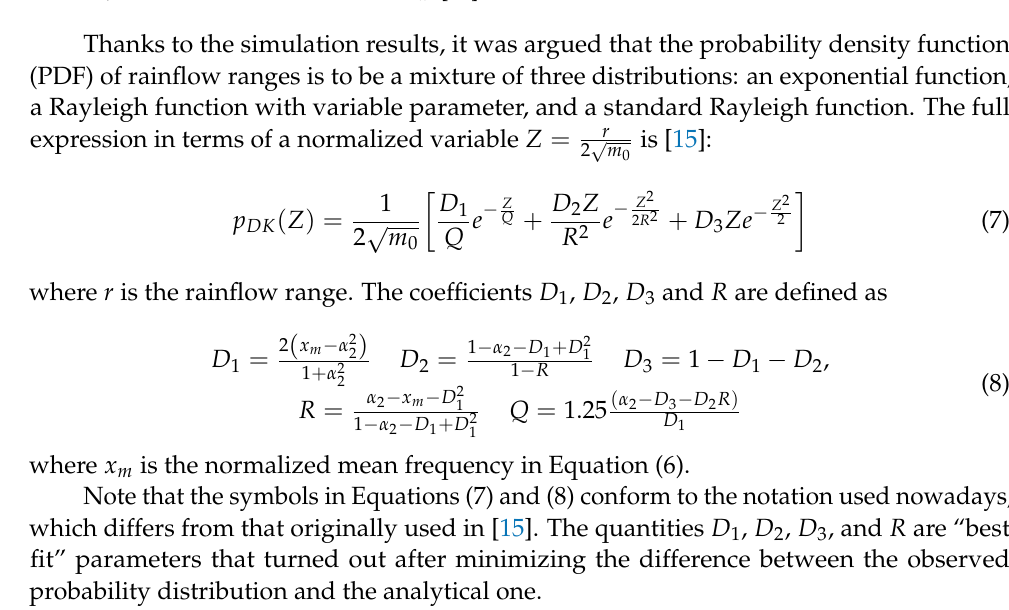
Figure 3. Probability distribution of: ( a ) simple ranges; ( b ) rainflow ranges. The numbers correspond to the irregularity factor of smooth PSD. On the x -axis, values are normalized as x /2 σ x